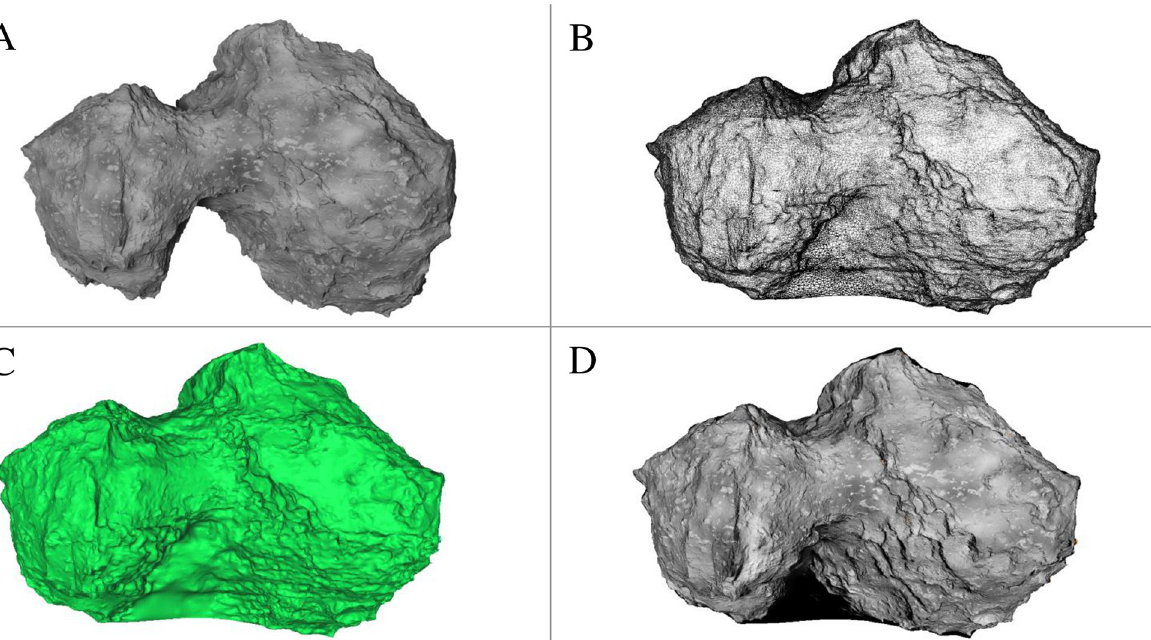
which would decrease the reconstructed accuracy; however, they can be implemented as dis- cussed in Subsection: Camera). The two furthest points and the closest approach are shown in Fig 13. The result of reconstruction is shown in Fig 14, which visualises vertices and the triangular mesh via the inclusion of normals and applied texture in the reconstructed model. As a result, two 3-D models are obtained: the input model for SISPO and the reconstructed model from images. Only the visible part of the comet was obtained because of the nature of